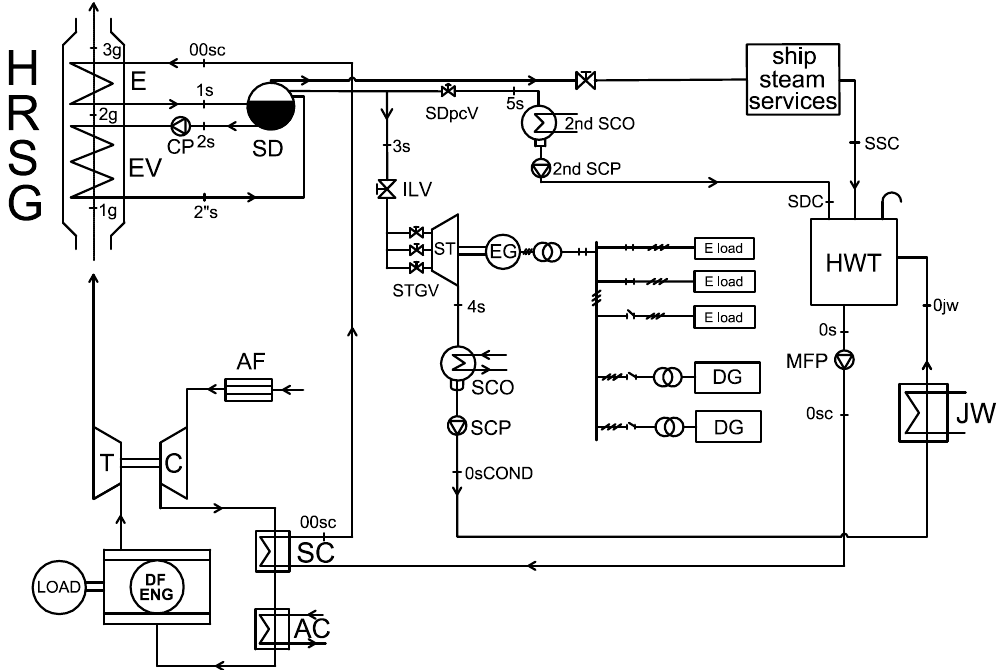
Figure 1. Waste Heat Recovery (WHR) system configuration.